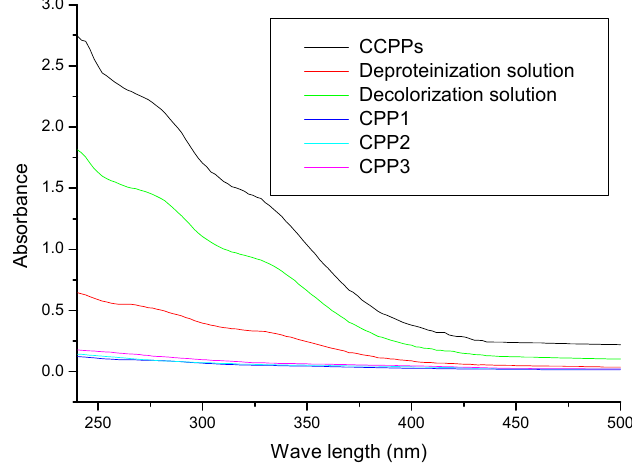
Figure 3. The UV-Vis spectra of the samples.